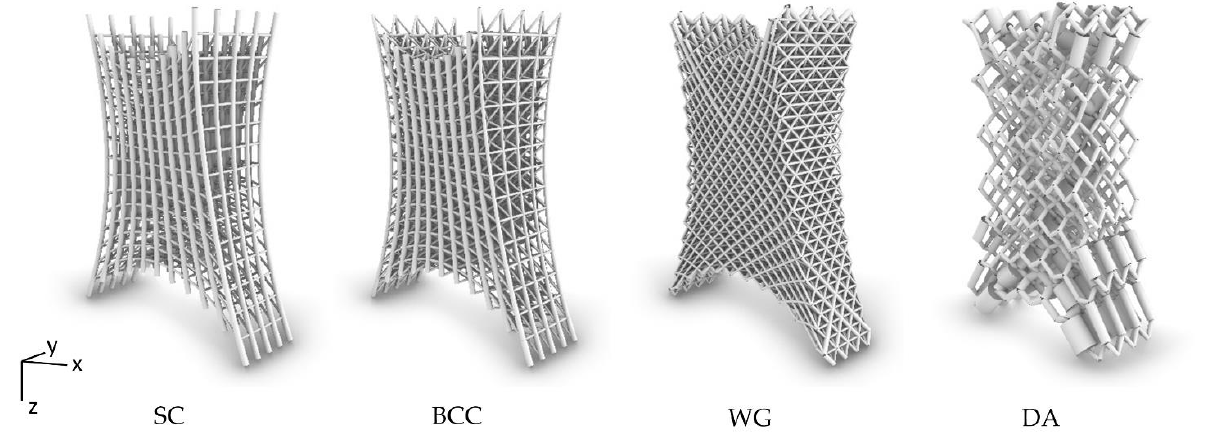
Figure 6. Optimized lattice structures for the compression load case inside Rhinoceros 7 design environment.